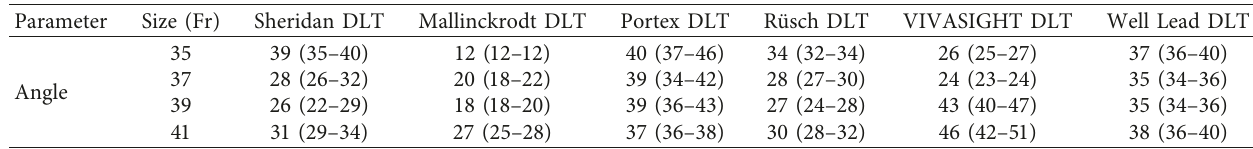
Table 6: Measured angles of the investigated left-sided double-lumen endobronchial tubes (DLTs) between a virtual longitudinal line through the middle of the tracheal tube shaft and bronchial tube (see also Figure